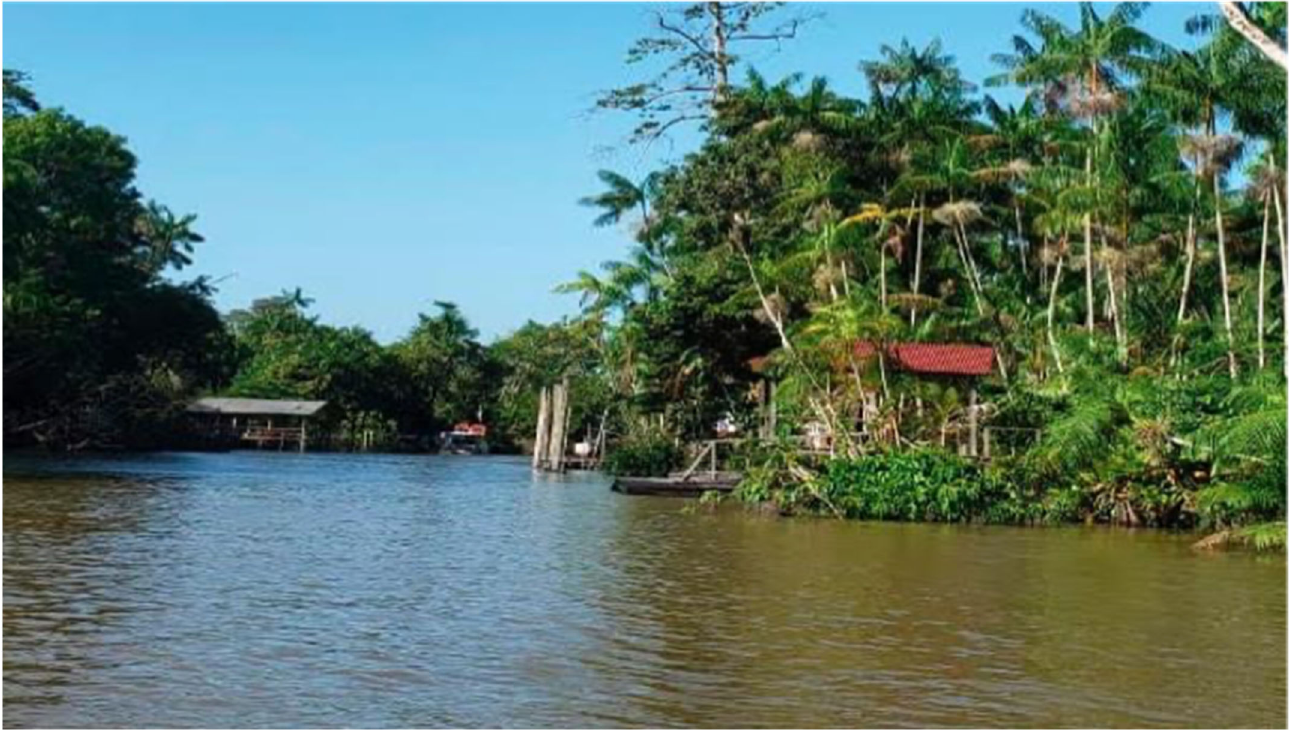
Figure 1. Combú Environmental Protection Area. Figure 1. Comb ú Environmental Protection